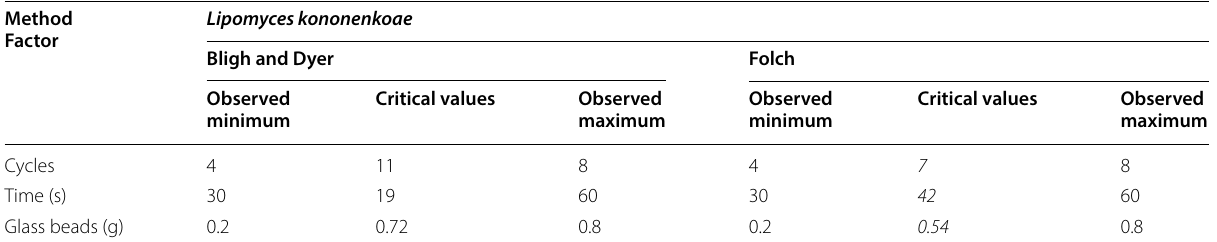
Table 4 Estimated optimum extraction conditions for the yeast Lipomyces kononenkoae using the Bligh and